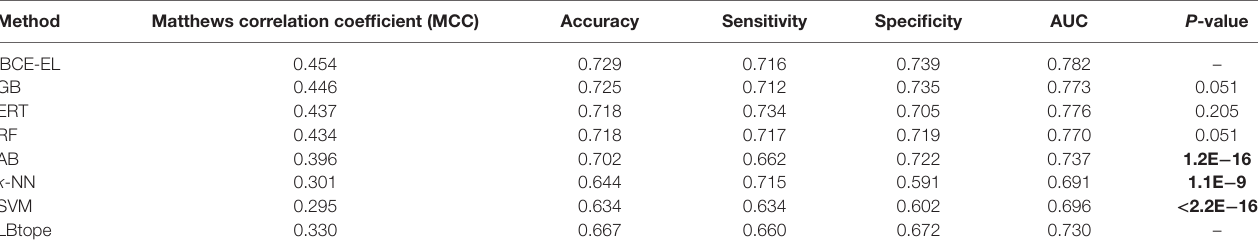
tABLe 1 | Performance comparison of iBCE-EL with other ML-based methods on the benchmarking data set.